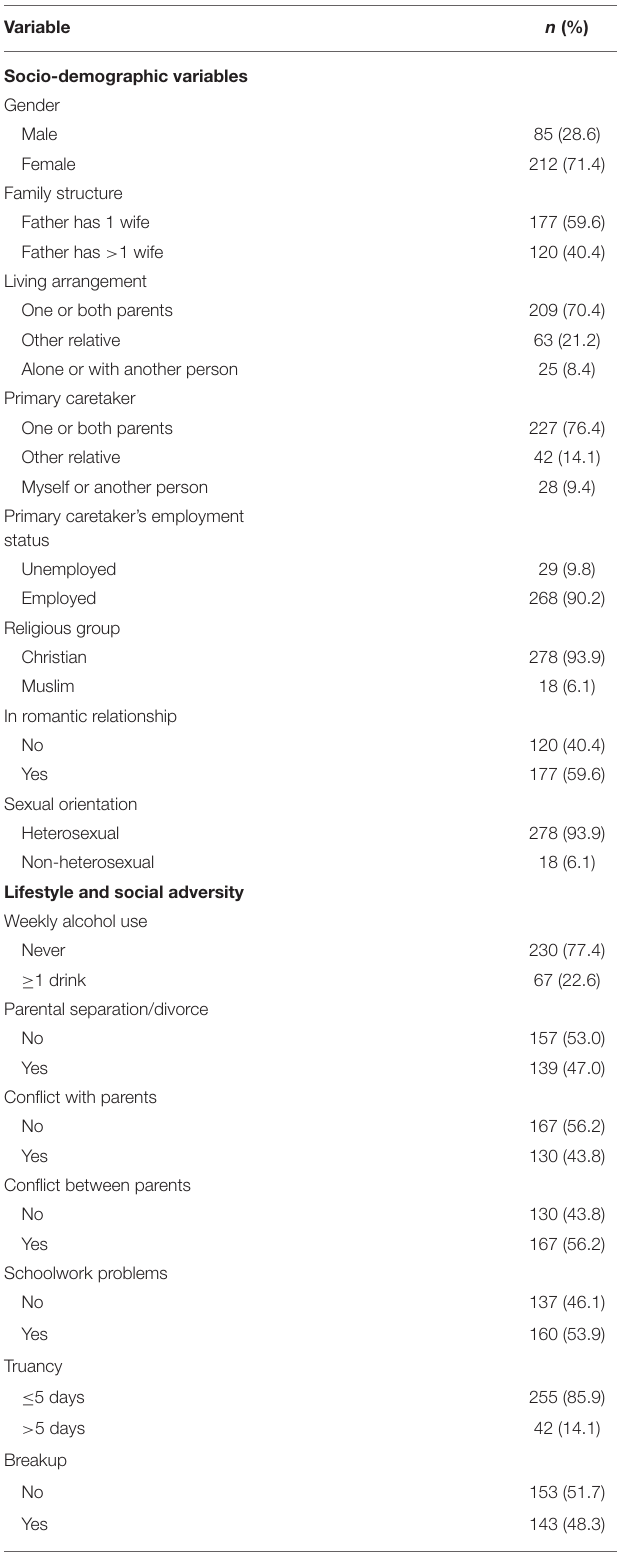
TABLE 1 | Distribution of sample across variables